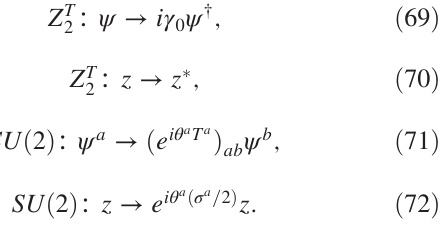
FIG. 7. A schematic phase diagram. The μ axis represents some parameter that can tune the transition from n ¼ 0 to n ¼ 3 SPT states with SO ð 6 Þ × Z T 2 symmetry in the free fermion limit. transitions, each of which is described by three massless Dirac fermions (or six Majorana fermions) in the bulk. However, there can be a single transition in the strongly interacting region. The critical theory for the single transition is the SU ð 2 Þ þ N A ¼ 3 f gauge theory, which is infrared-free. The phase diagram shows one natural postulation about the intermediate coupling regime of the phase diagram. The three weakly coupling phase transitions may merge into a single multicritical point, which could be described by an SU ð 2 Þ þ N A ¼ 3 QCD 4 -Higgs f